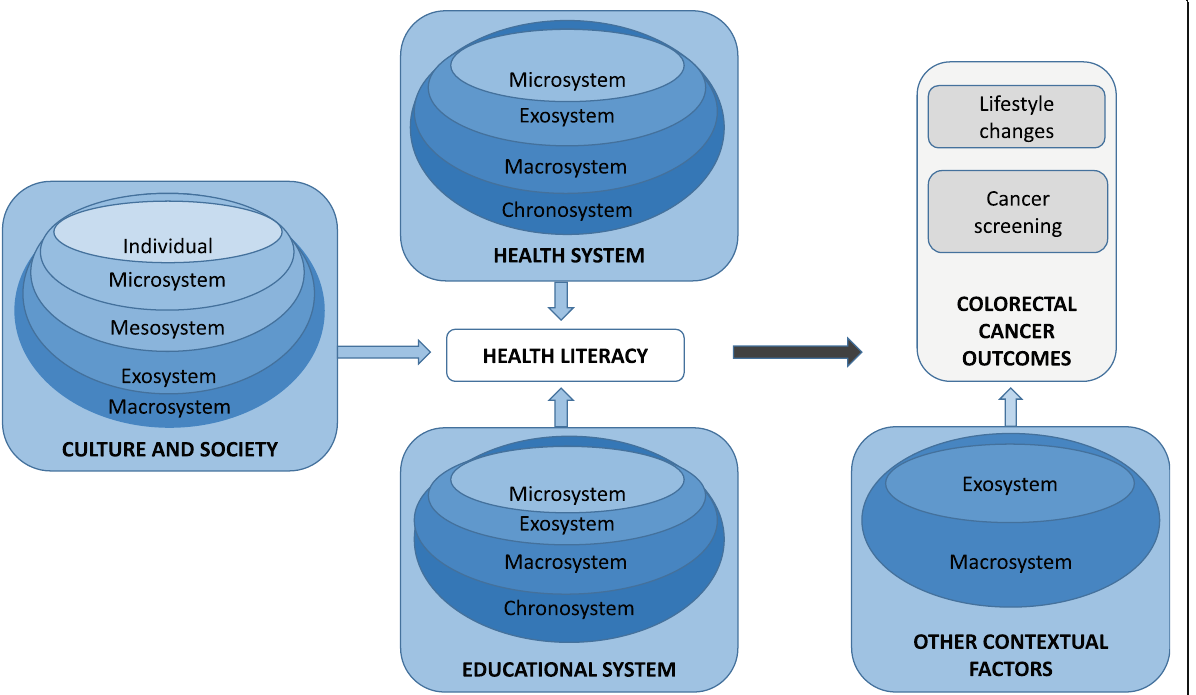
Fig. 1 Integration of ecological theory and the health literacy model depicting factors that influence CRC